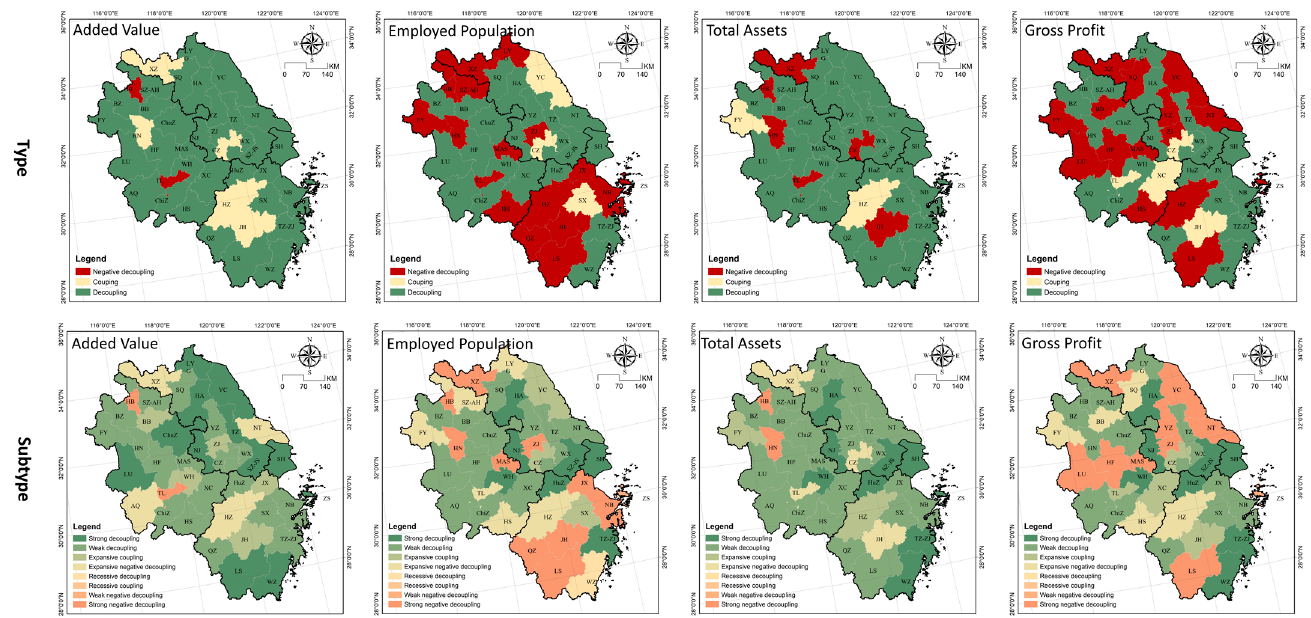
Figure 12. Spatial analysis of the decoupling types in the YRD .